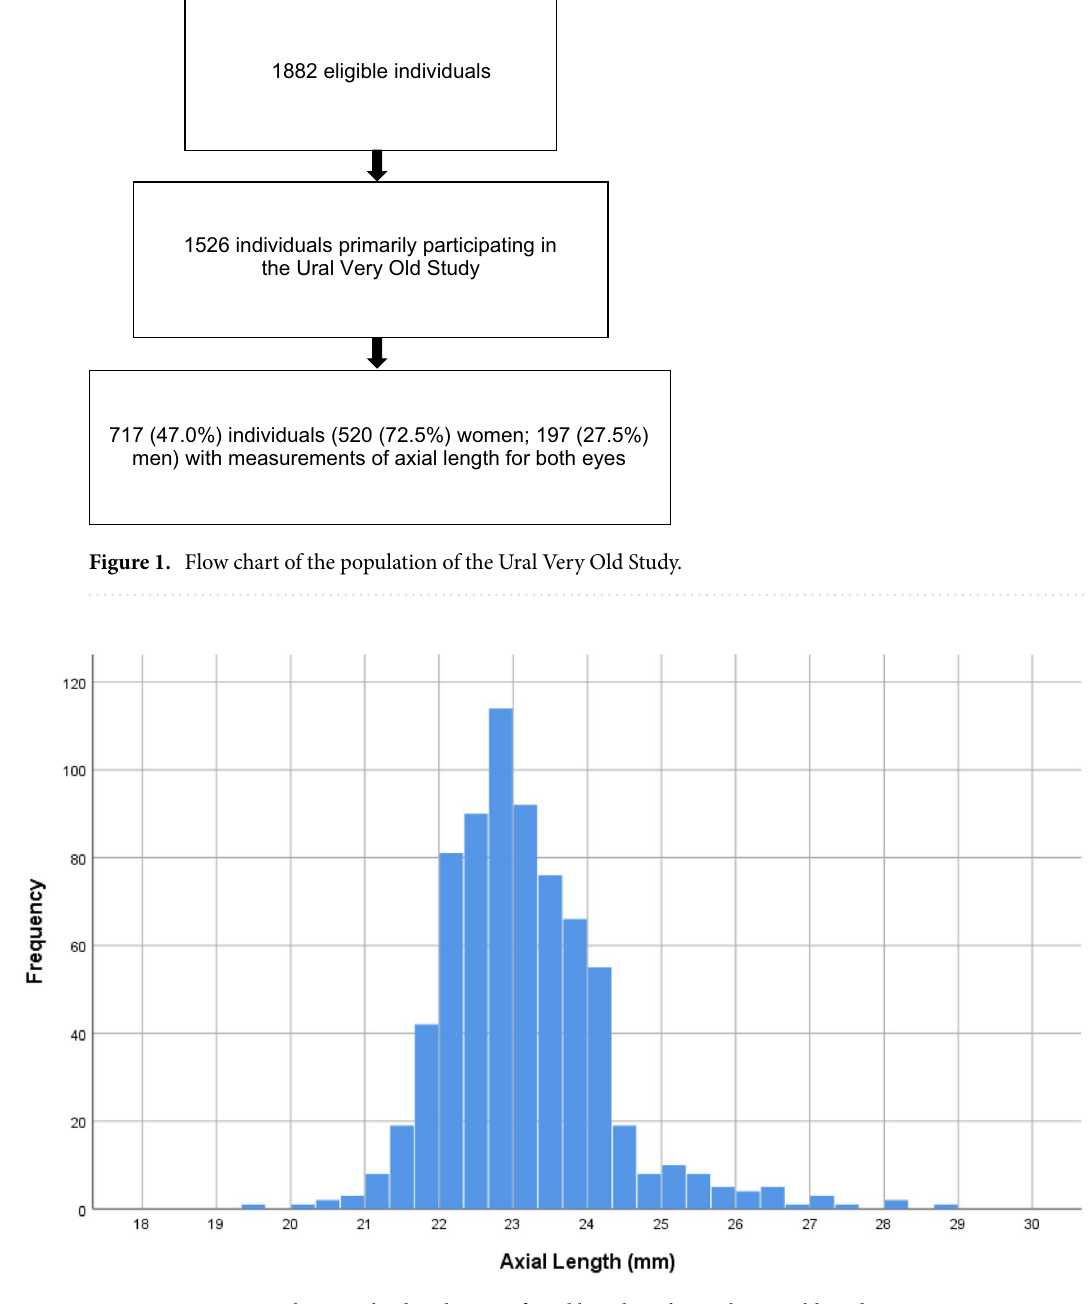
Figure 2. Histogram showing the distribution of axial length in the Ural Very Old